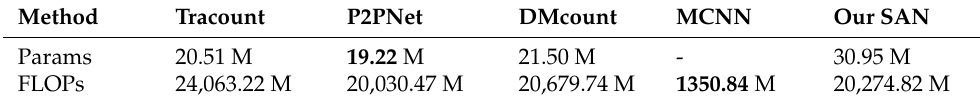
Table 2. Parameter comparison with multiple methods. The best values are highlighted in boldface.